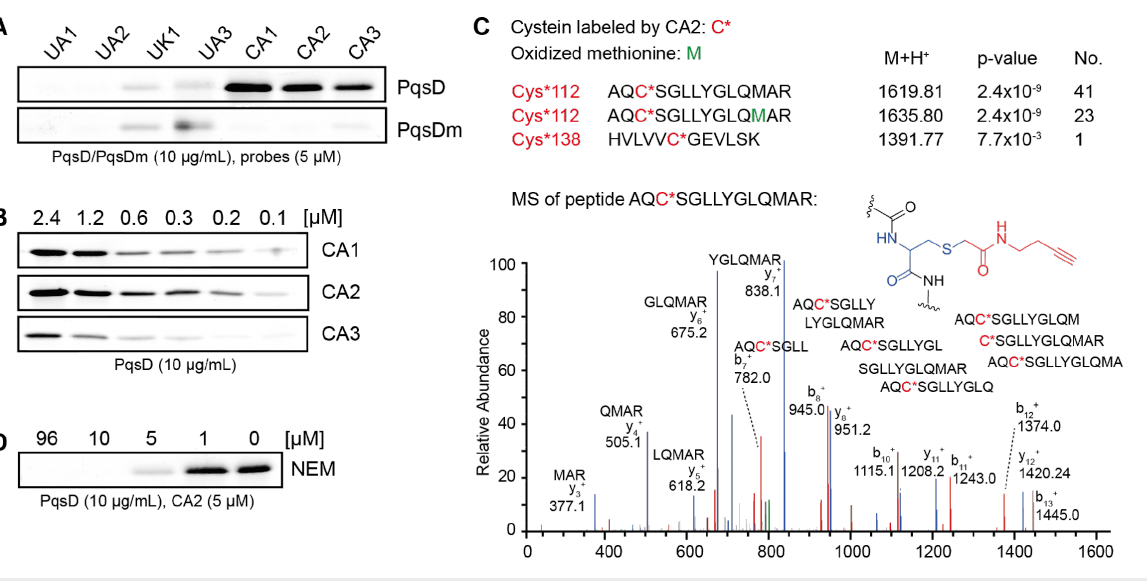
Figure 3: In vitro labeling of PqsD by chemical probes. A) ABPP probe library with wild-type PqsD and PqsD C112A mutant (PqsDm). B) Concentra- tion dependence of labeling by the three active site directed probes. C) Mass spectrometric discovery of tryptic peptide fragments with probe CA2 at- tached to the active site Cys112 (No.: number of detected peptides). D) Competitive experiment with N -ethylmaleimide and probe CA2